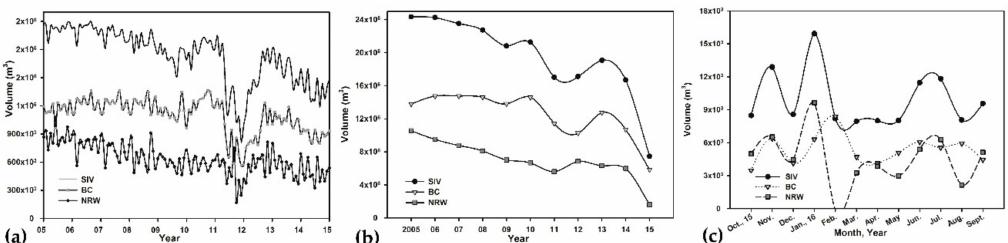
Figure 3. Fluctuation in the NRW volume according to changes in SIV: ( a ) monthly basis for the full-scale system; ( b ) annual basis for the full-scale system; ( c ) monthly basis for DMA-1 in Hadda Zone,